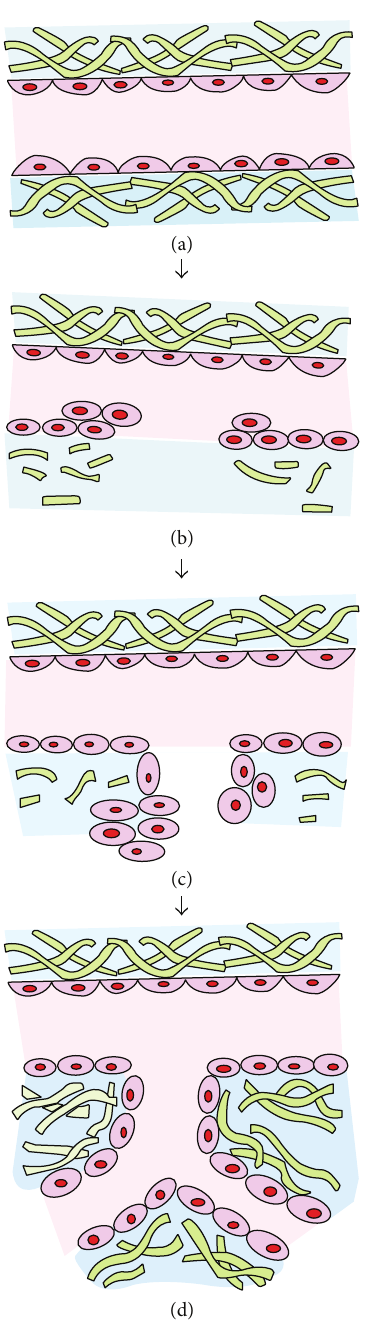
Figure 1: Stages of angiogenesis process. (a) Normal, quiescent intestinal vessel: endothelial cells (ECs) with smooth basal mem- brane and regular extracellular matrix (ECM) are seen. (b) After angiogenic stimulation, activated EC secretes various proangiogenic and proinflammatory molecules. Then, increased permeability, vasodilatation, and extravasation of leucocytes occur. Basal mem- brane and ECM are degraded by metalloproteinases and proteases. ECs proliferate and migrate from this degraded area. After sprout- ing, ECs adhere to the matrix. (c) Tubulogenesis, lumen formation, and beginning of stabilization. (d) Remodeling and maturation: angiogenesis is completed in this stage by migration of pericytes and vascular smooth muscle cells to this area. If maturation of this new vessel is not completed, angiogenesis continues as pathogenic